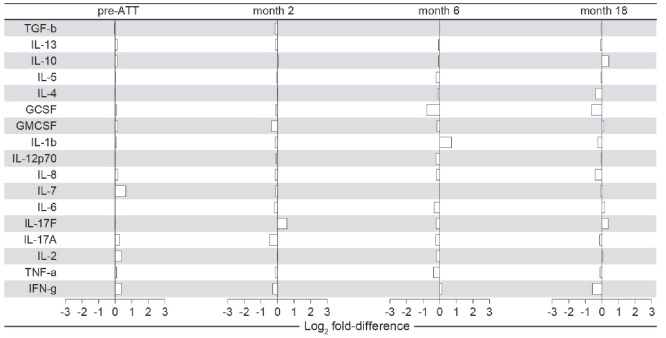
Biomarker profiles in India cohort TBDM participants with KDM vs NDM at enrollment.Mean fold-differences at each timepoint are compare participants with known DM diagnosis prior to enrollment (KDM) vs those newly diagnosed with DM at enrollment (NDM). Comparisons were analyzed using the Mann-Whitney U test and adjusted for multiple comparisons. There were no statistically significant differences between the two groups.